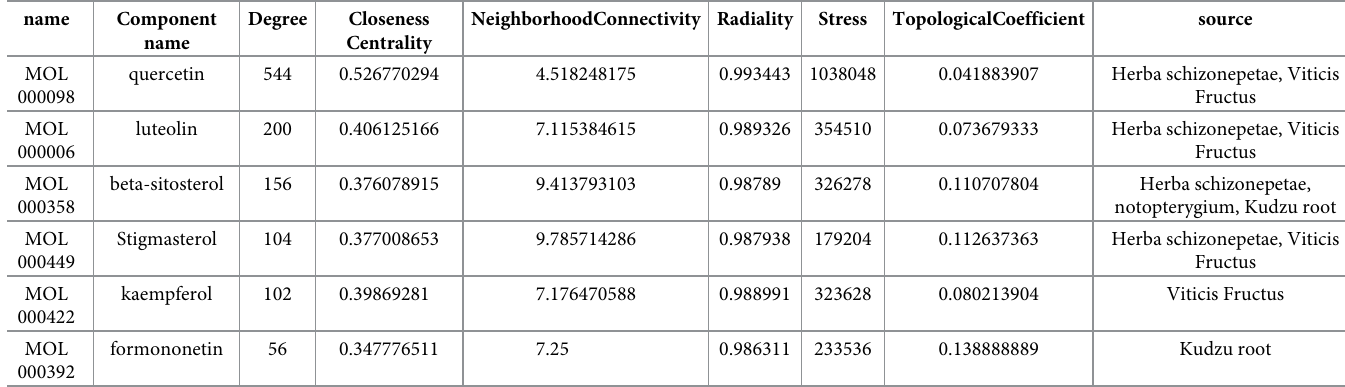
Table 4. Core active ingredient screening list for